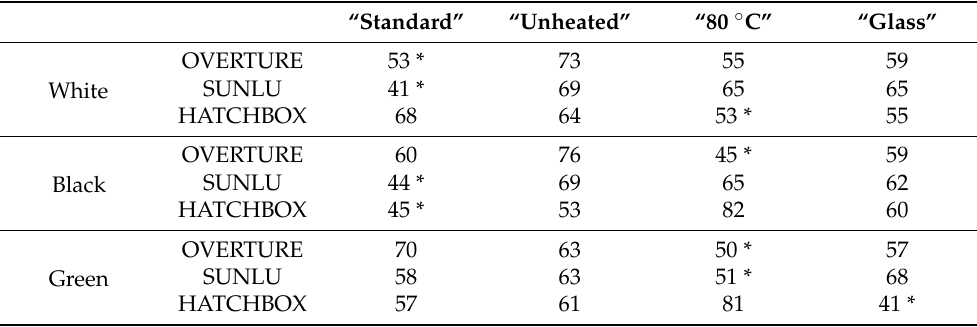
Table 3. Filament scoring across all four printer conditions, with varying bed temperature and bed surface, produces S Combined values based upon the contributions from dimensional accuracy and mechanical properties (* optimal parameter set identified for a given filament).